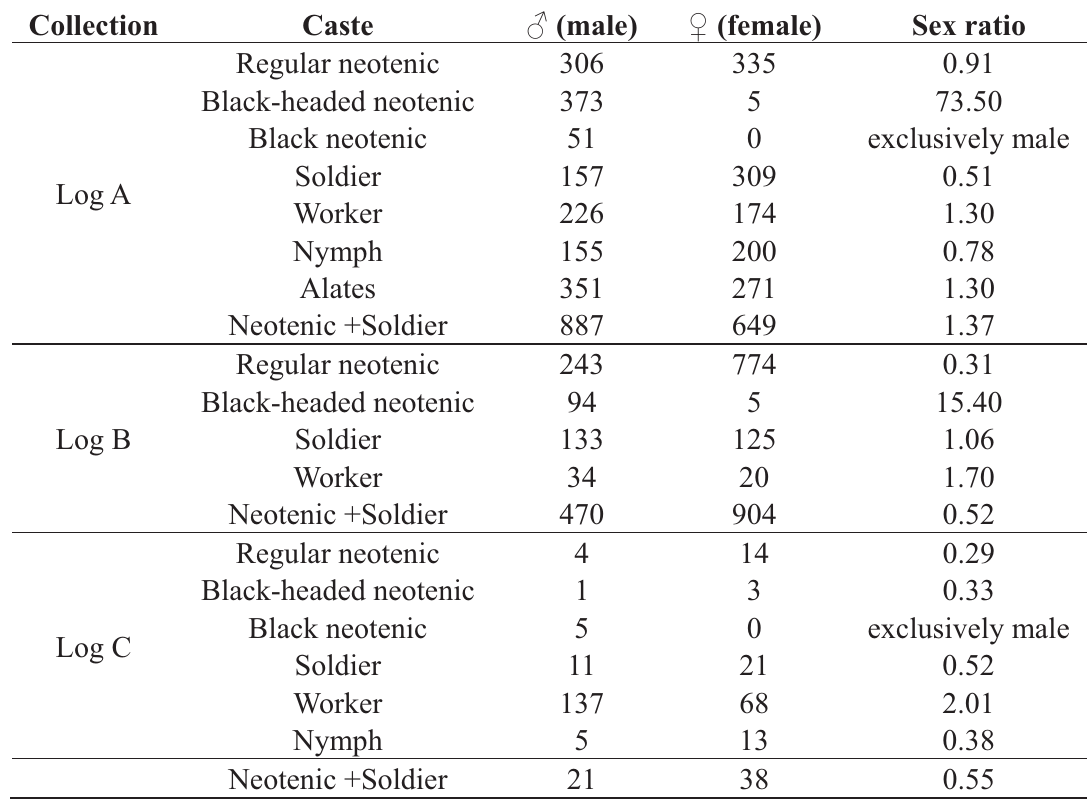
Table 1. List of castes collected from three logs by caste, including neotenic phenotypes, number examined and resulting sex